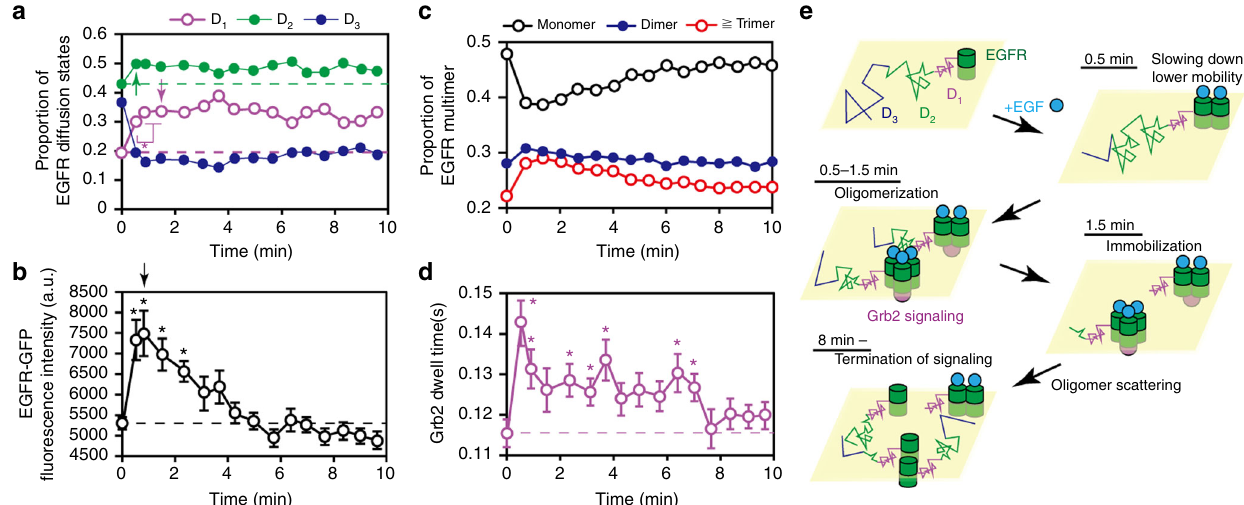
Fig. 5 Time course of EGFR behavior after EGF stimulation. a Temporal changes in the fractions of the three EGFR states. Magenta, green, and blue circles indicate the immobile, slow-mobile, and fast-mobile fractions, respectively. Arrows indicate the fi rst peaks of the immobile and slow-mobile states. The SE is shown in Supplementary Figure 8b. b Fluorescence intensity changes of EGFR-GFP. The arrow indicates the maximum intensity. c Cluster size changes calculated based on the fl uorescence intensity histogram at each time point. Black, blue, and red circles indicate monomers, dimers, and oligomers larger than dimers, respectively. d Changes in the residence time of Grb2 on the plasma membrane. The dotted lines shown in a , b , and d indicate data obtained before the EGF addition. Asterisks indicate signi fi cant differences compared to the data from before the EGF addition (* P < 0.05). The number of data points is shown in Supplementary Table 1. Error bars: SE. e Scheme of the EGF-induced (cyan circle) behavioral transitions in EGFR (green cylinders), along with the receptor-evoked cell signaling via Grb2 (magenta circle). Magenta, green, and blue lines indicate immobile, slow-mobile, and fast-mobile